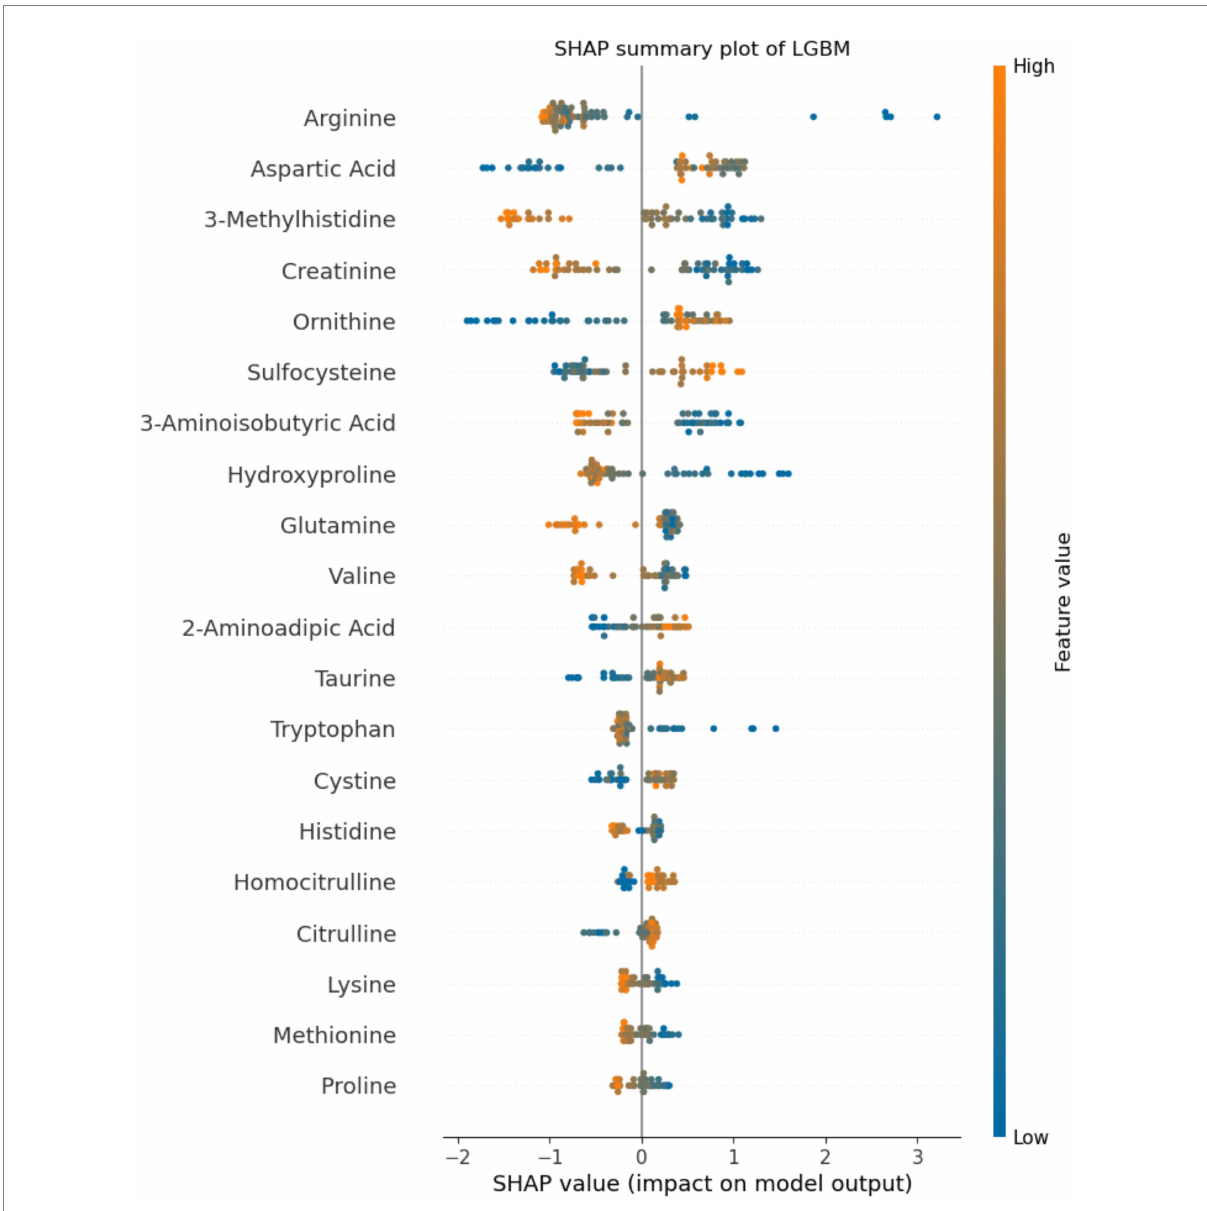
FIGURE 2 Feature importance analysis by SHapley Additive exPlanation (SHAP) values. The top 20 amino acids by percentage importance using the SHAP method are presented by amino acid. The colors indicate the association between feature value and positive SARS-CoV-2 classification, with features pushing the risk of SARS-CoV-2 higher in blue, and features pushing the risk of SARS-CoV-2 lower in orange. The axis scale represents the predicted SHAP output value scale. Positive SHAP values indicate positive impact on model prediction (leading the model to predict SARS-CoV-2- positive), whereas negative SHAP values indicate negative impact on model prediction (leading the model to predict